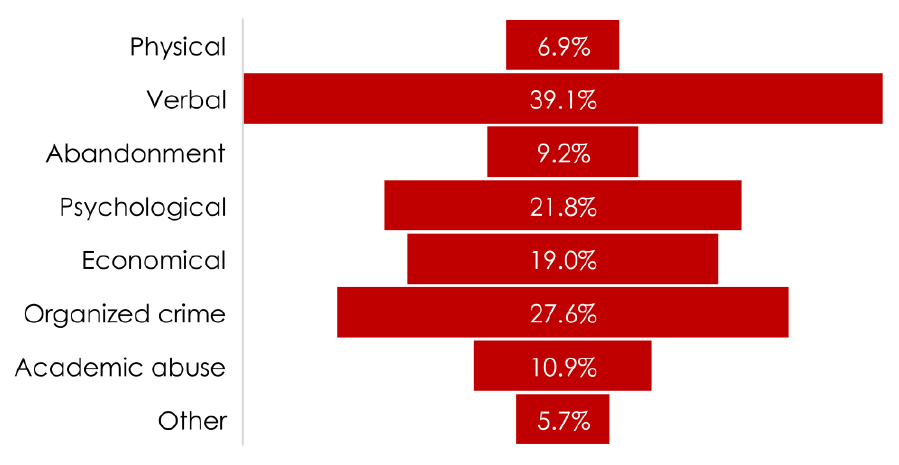
Figure 2. Frequency of the main types of violence identified by SSMIs ( n = 157). As a single participant could be a victim of more than one type of violence, each bar represents an independent frequency calculated based on the total number of incidents.